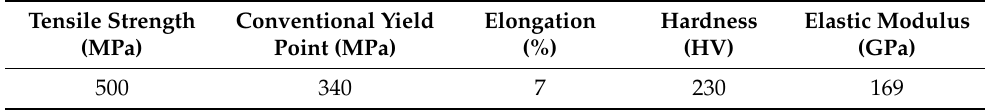
Table 1. Mechanical properties of EN-GSJ-500-7.